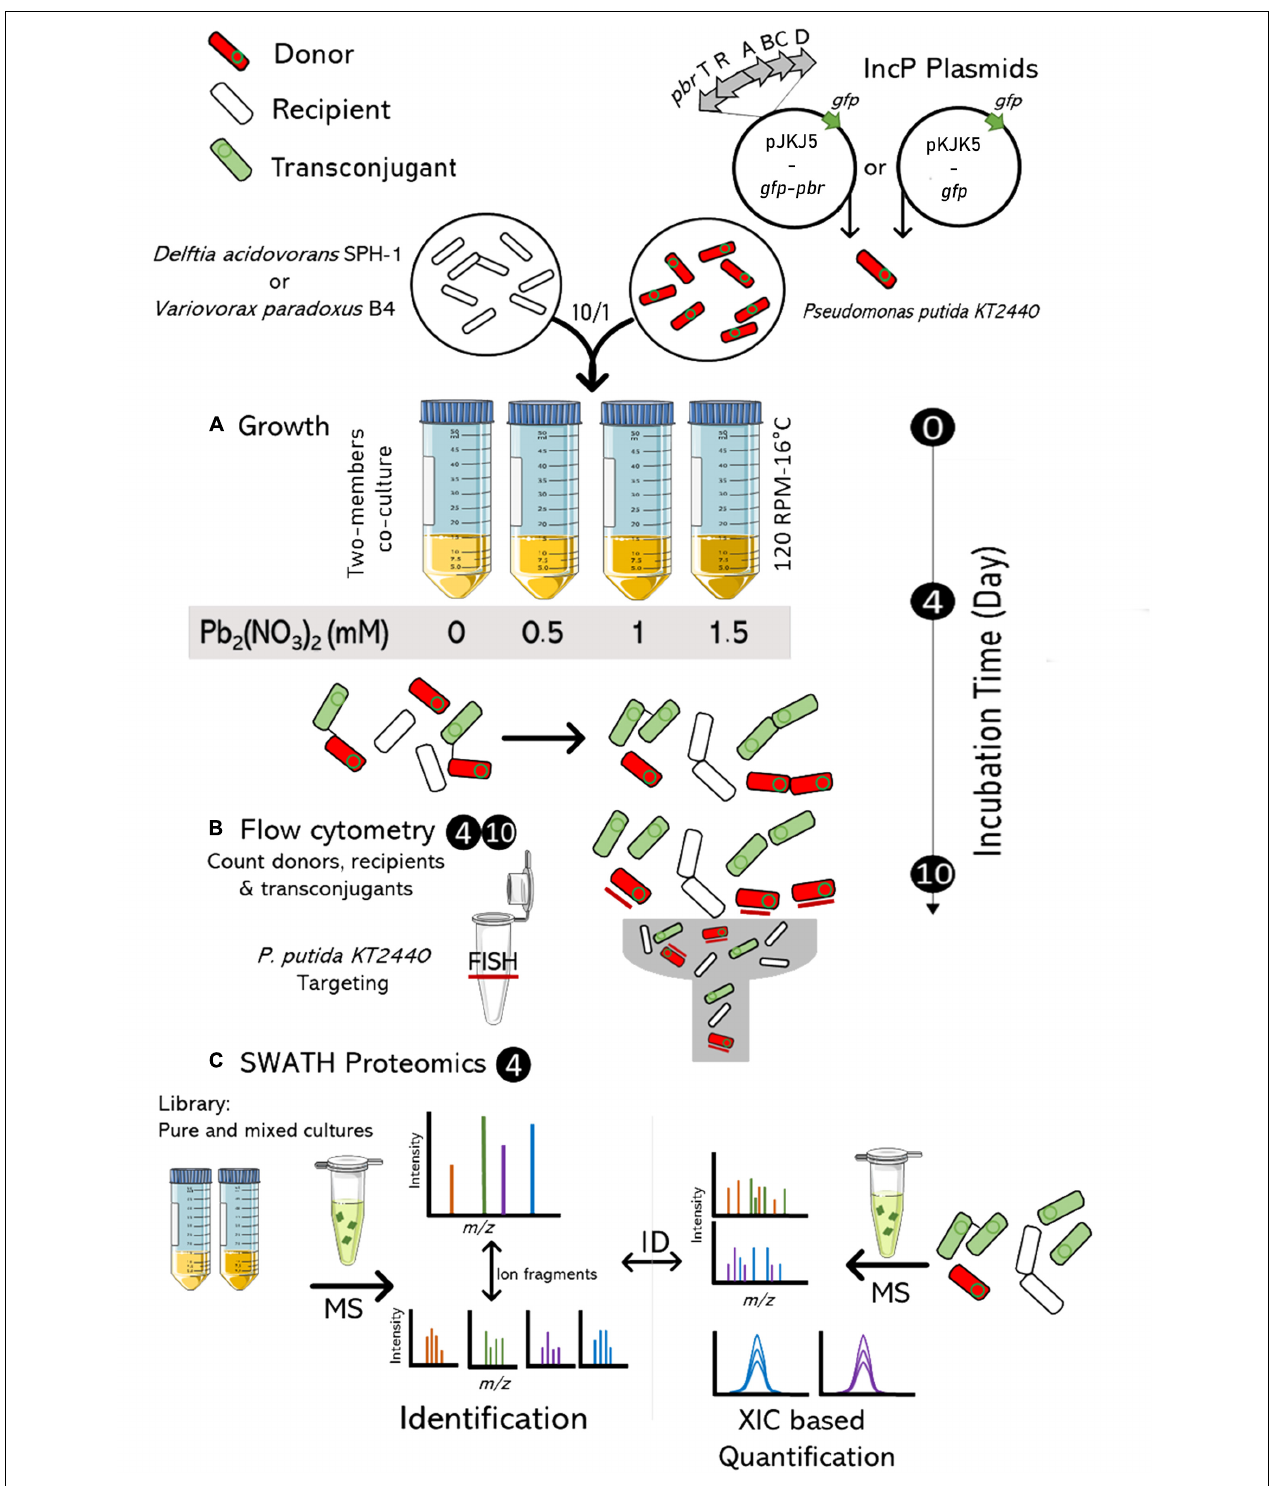
FIGURE 1 | Experimental design combining flow cytometry and proteomics to assess lead impact on the functional profile of a mating coculture and the spread of the plasmid. Recipient and donor cells were grown (10/1 ratio) in LB3D (120 RMP, 16 ◦ C) over 10 days with an increasing concentration of Pb 2 (NO 3 ) 2 (0, 0.5, 1, 1.5 mM) (A) . After 4 and 10 days, flow cytometry was used to quantify recipient, donor (FISH labelled) and transconjugant cells (B) . After 4 days, they were also analyzed by SWATH-MS proteomics (C) . MS: Mass spectrometry; m/z : mass-to-charge ratio; XIC: extracted ion chromatogram.